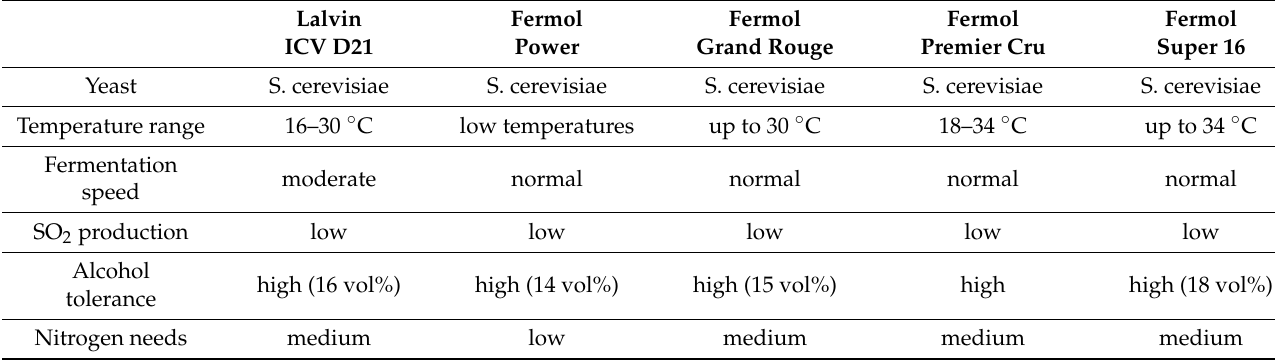
Table 1. Main characteristics of used yeast strains.